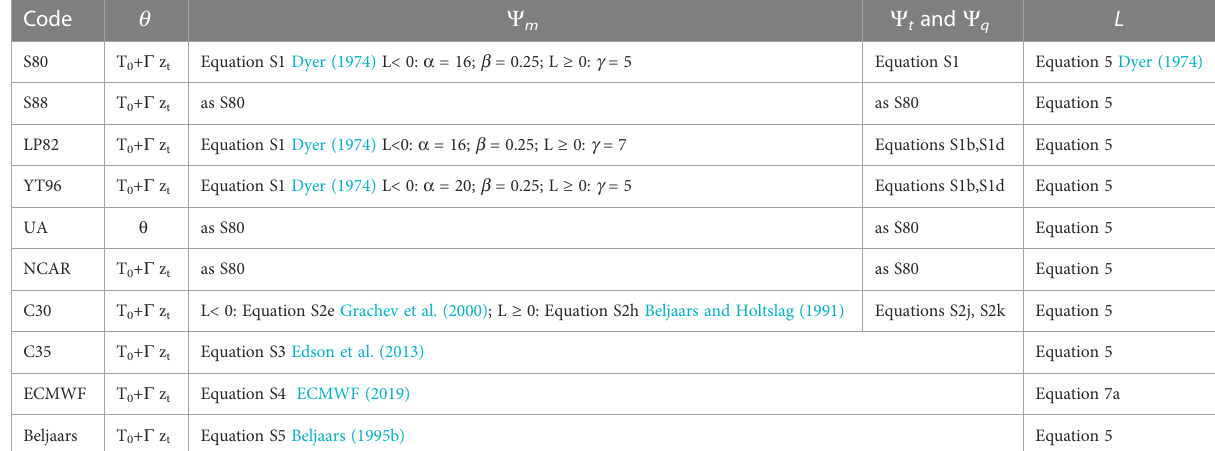
TABLE 3 Summary of terms used in the algorithms: Potential Temperature [ q (K), where Г is the lapse rate ( Table S1 )]; Stability functions for momentum ( Y m ) and temperature ( Y t and Y q ; the equations are given in Section S6); Monin-Obukhov length [L (m)].